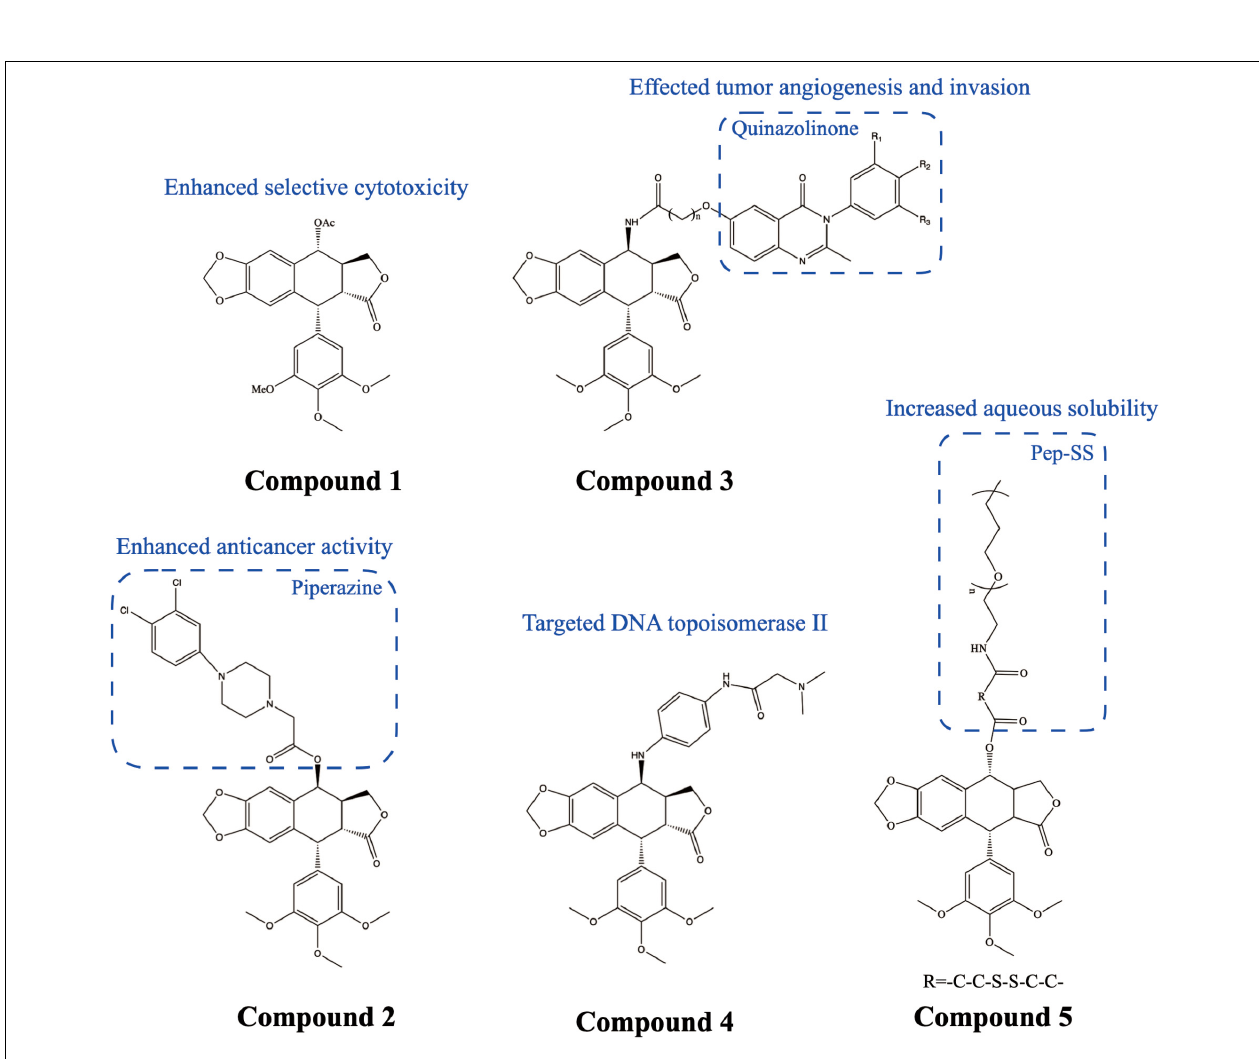
FIGURE 2 | Chemical structures and therapeutic highlights of PTOX derivatives Compound 1–5.